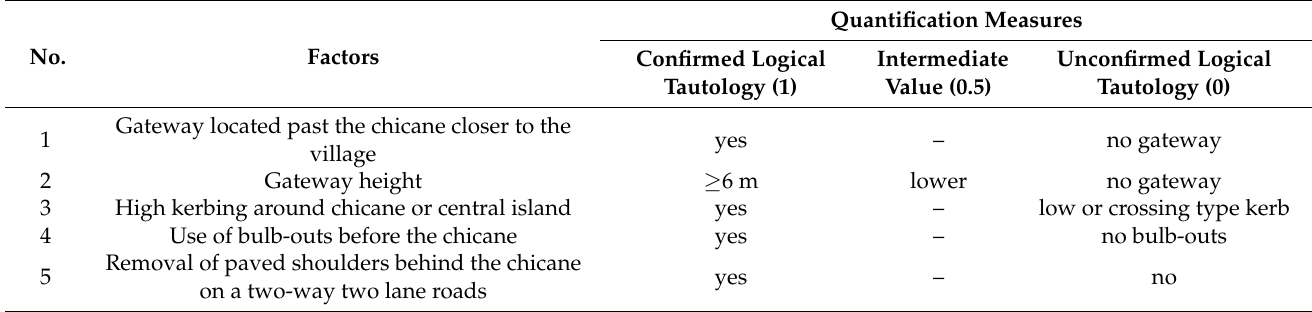
Table 6. Additional factors and their corresponding quantification measures.